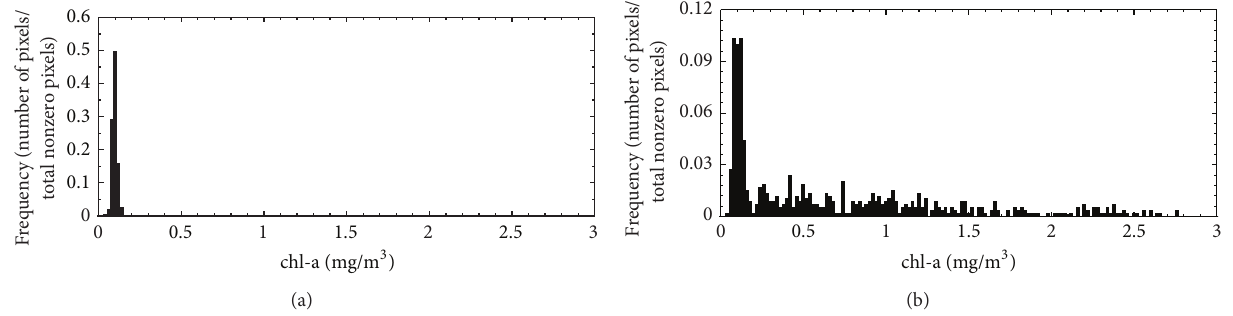
Figure5:Frequencydistributionofavailablechl-apixelvaluesintheCCEareaderivedfromprestormandpoststormimages.(a)Theprestorm chl-a distribution. (b) The poststorm chl-a distribution.